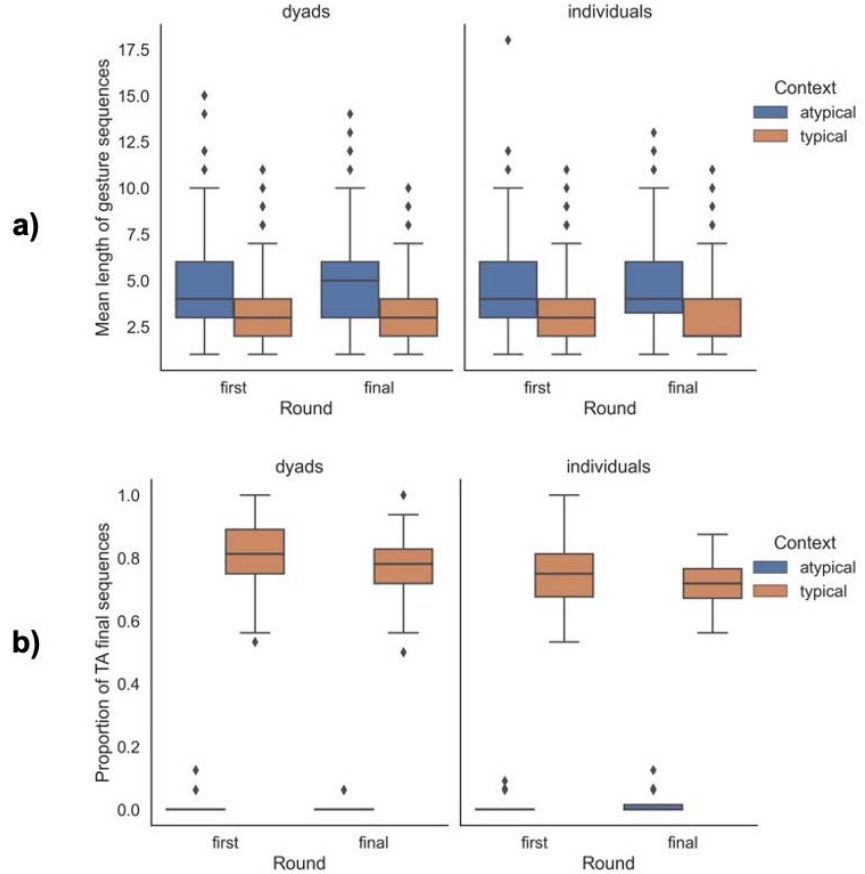
Figure 9. Mean gesture length ( a ) and Proportion of gesture sequences with target action (TA) in final position ( b ), shown for each round and each context (typical/atypical). Size. Figure 10c indicates that participants produce a high proportion of path ges ‐ tures across rounds and contexts, for both dyads and individuals. Analysis using a logistic mixed effects model to predict path gesture production did not find an improved fit over the null model when including either context ( χ 2 = 0.55, p = 0.46), or context and round ( χ 2 = 1.07, p = 0.30) as fixed effects, suggesting no reliable changes in the preference for path gestures across contexts and rounds. Repetitions. We show the proportion of trials with repeated targets in Figure 11, and use a logistic mixed effects model including context, round, group, and iterability of the target action as fixed effects, along with their interactions. A model including all fixed effects and interaction terms showed improved fit over a reduced model ( χ 2 = 26.32, p = 0.006). Inspection of the model revealed a main effect of iterability ( β = − 4.22, SE = 0.72, z = − 5.87, p < 0.001) and an interaction between round and iterability ( β = − 1.39, SE = 0.36, z = − 3.92, p < 0.001). Participants in both groups produce more repetitions for iterable than non ‐ iterable target actions. For iterable items, repetitions increase between the first and final round but decrease between the rounds for non ‐ iterable items.